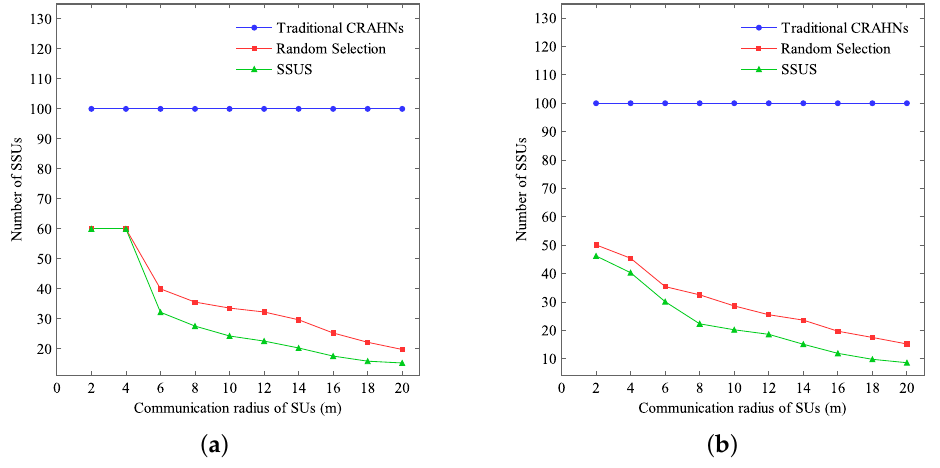
Figure 6. Number of SSUs vs. communication radius of SUs. ( a ) Network size is 100 × 100 m 2 , ( b ) Network size is 60 × 60 m 2 .